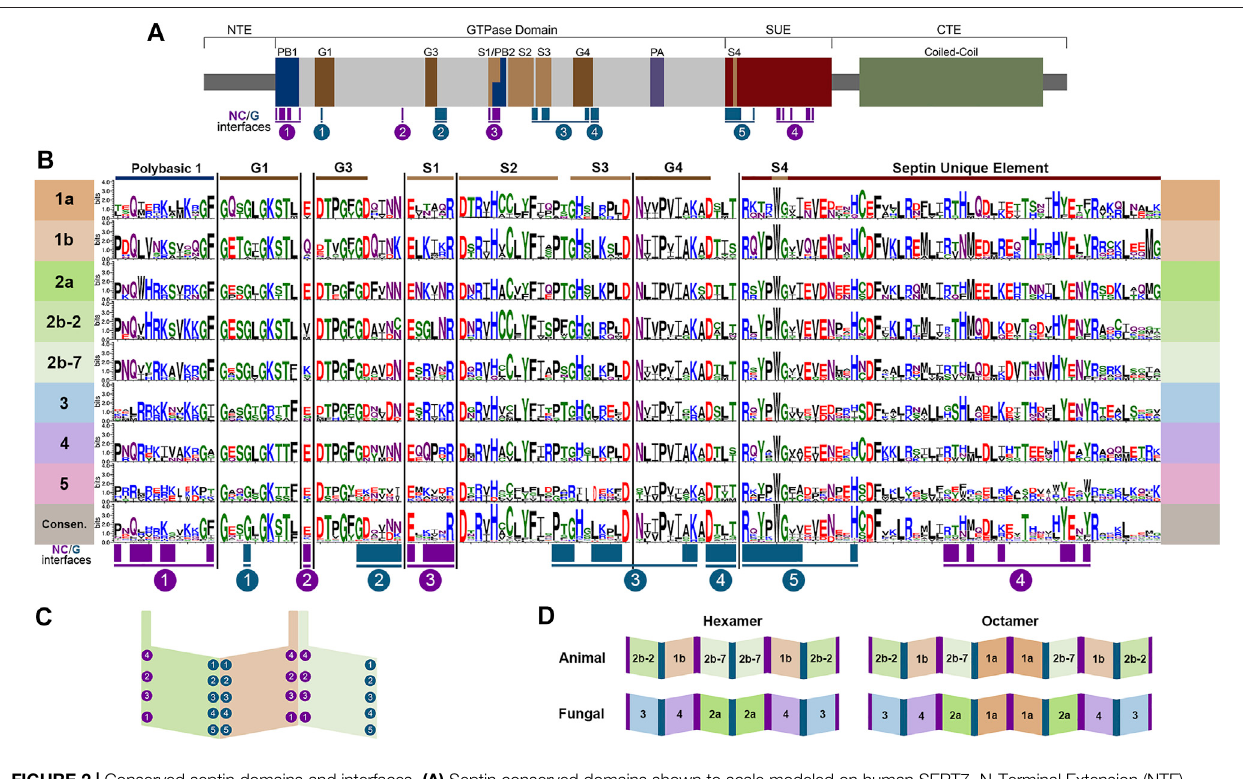
Frontiers in Cell and Developmental Biology |